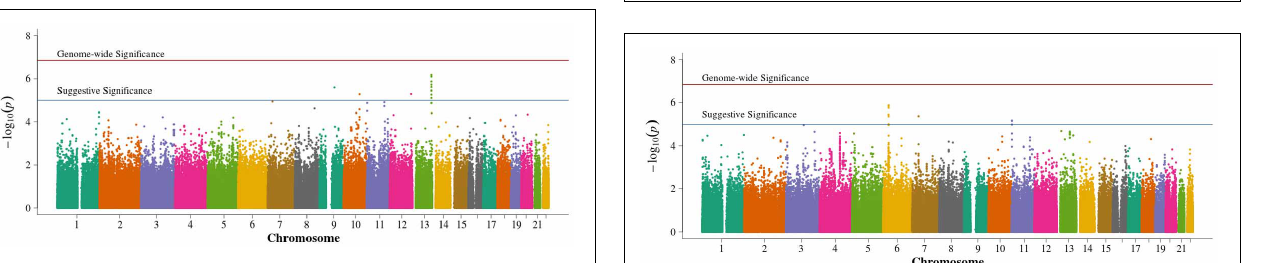
FIGURE 2 | Manhattan plot for population-based study with pooled singletons and trio probands. Summary of genome-wide association scan results in the GoKinD population-based singletons and trios combined. The − log 10 P -values were calculated for SNP association with diabetic nephropathy among subjects with type 1 diabetes using the Cochran-Armitage test for trend for an additive genetic model adjusted for sex and stratified by center ascertainment using Cochran-Mantel-Haenszel method. The red horizontal line corresponds to genome-wide significance ( P -value = 0 . 05 / 357 , 887 = 1 . 4 × 10 − 7 ). The blue horizontal line corresponds to suggestive significance ( P -value = 1 × 10 − 5 ).